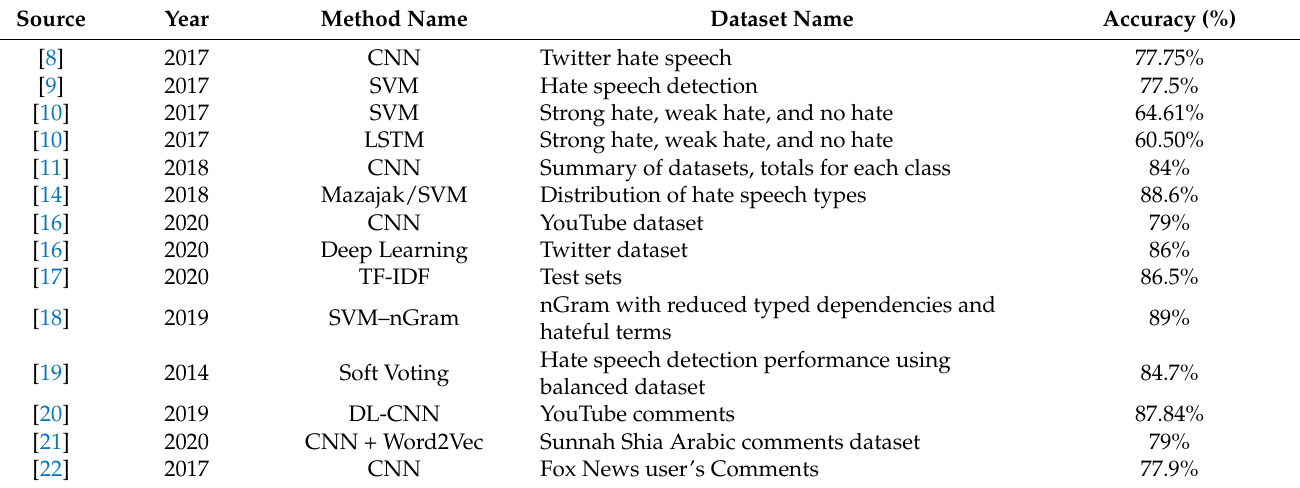
Table 1. Summary of recent studies on text